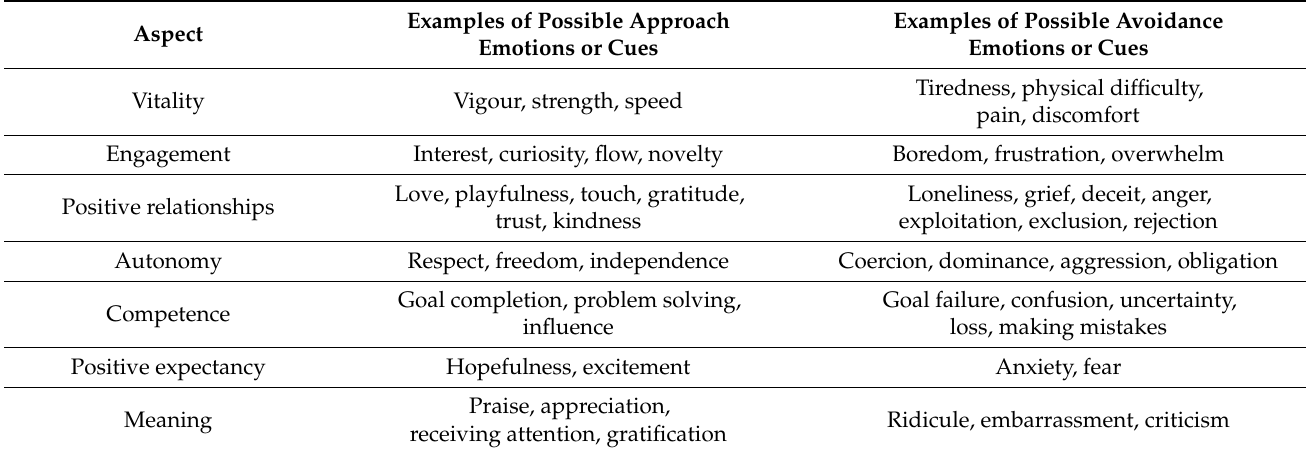
Table 4. Examples of possible cues and emotions for wellbeing